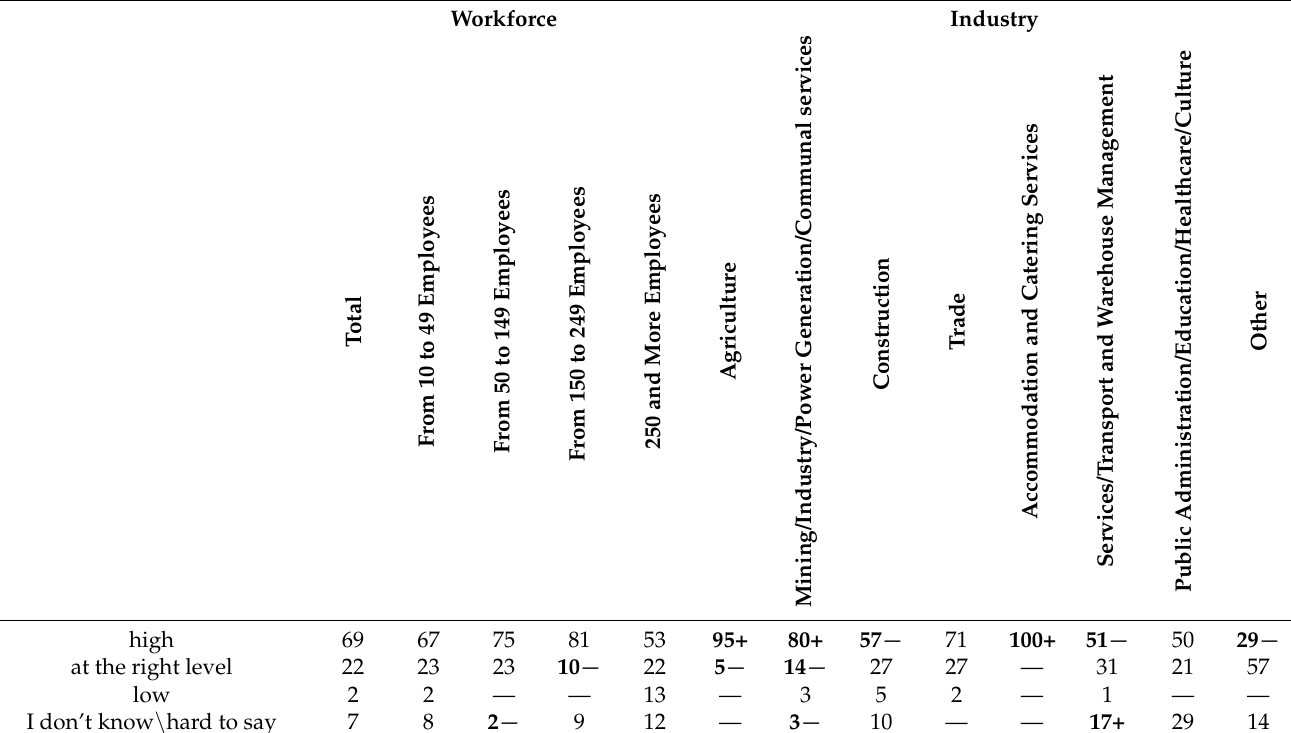
Table 2. Electricity prices assessed by entrepreneurs—by company size and industry (answers in percentage points). Are the current electricity prices in Poland in relation to the total costs of running a business?